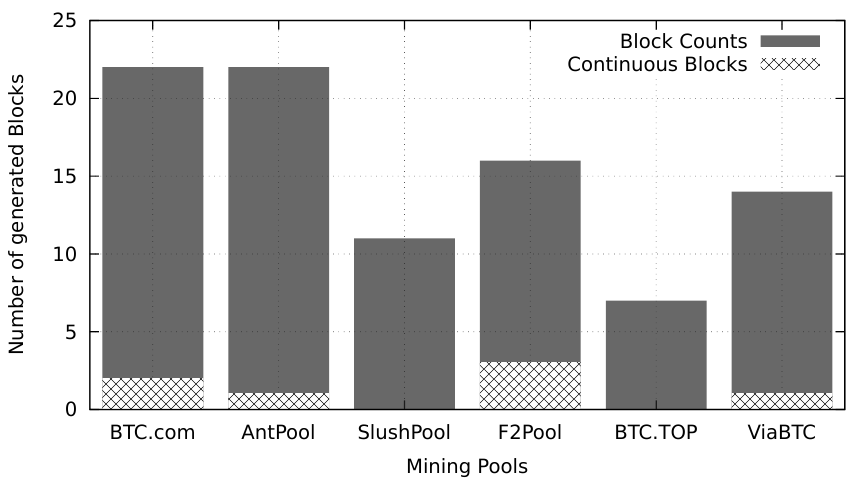
Figure 5. Total number of continuous blocks ≥